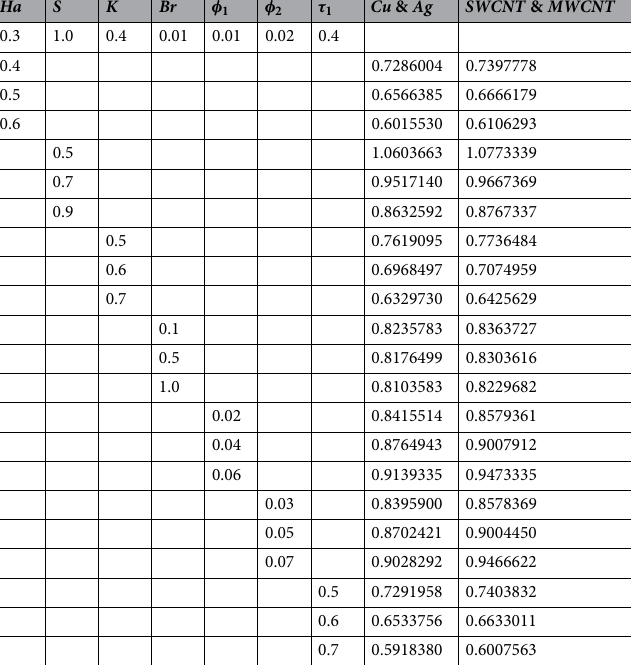
Table 3. Numerical results of Nusselt number when S 1 = S 2 = 0.5, β 1 = 0.02, β 2 = 0.03, τ = 0.4 with boundary condition θ ′ ( 0 ) = 0